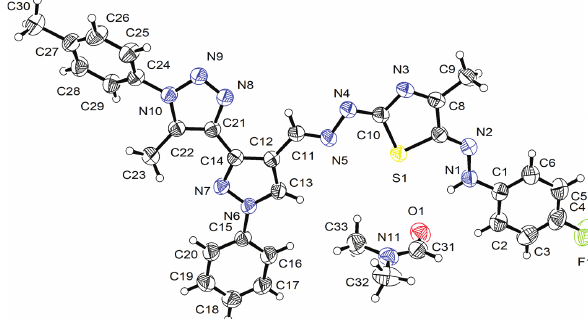
Table 1: Data collection and